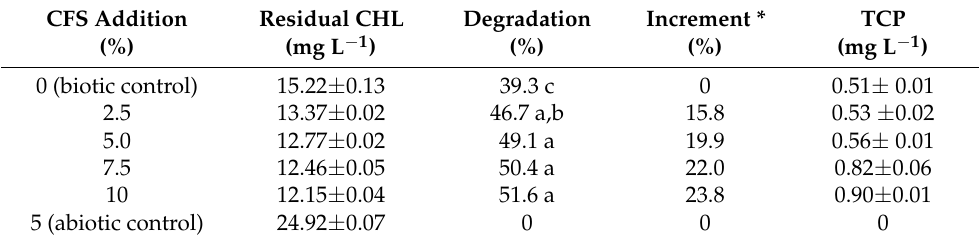
Table 2. Degradation of CHL and formation of its metabolite 3,5,6-trichlo-2-pyridinol (TCP) in LB medium with biosurfactant addition obtained from Pseudomonas rhodesiae strain